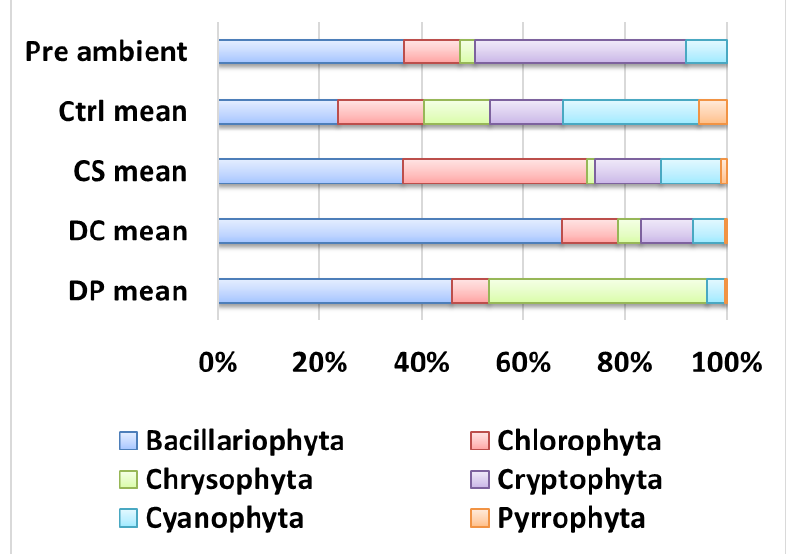
Figure 5. Mean taxonomic composition of the phytoplankton in the untreated pre-incubation lake water (“Pre ambient”) and in the experimental mesocosms after 7 days of in situ incubation. Ctrl: control; CS: plant particles; DC: calibration beads; DP: body wash MPs. Water 2020 , 12 , x FOR PEER REVIEW